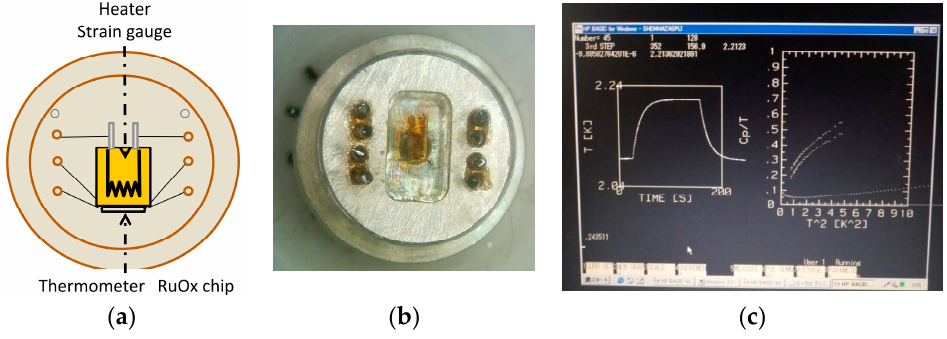
Figure 2. Schematic ( a ) and photograph ( b ) of the relaxation calorimetry cell used to measure the heat capacity of small amounts of samples of molecule-based compounds. Photograph ( c ) shows the relaxation curvature in the measurement.